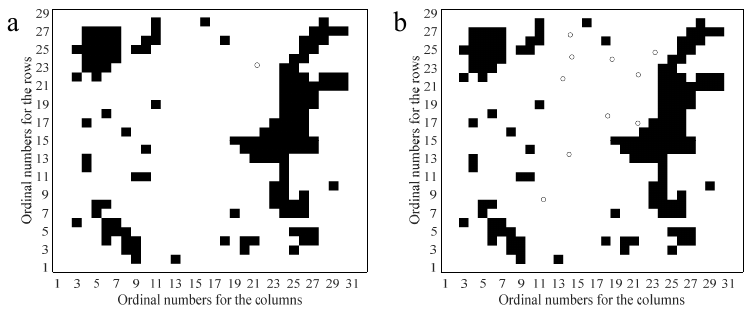
Figure 19. Detecting point selection based on PSO. ( a ) Single detecting point selecting process. ( b ) Multiple detecting point selecting results. Note that, to display the location of the detecting point clearly, grid lines are omitted. Table 2. The particle position and fitness for each iteration in the search process.